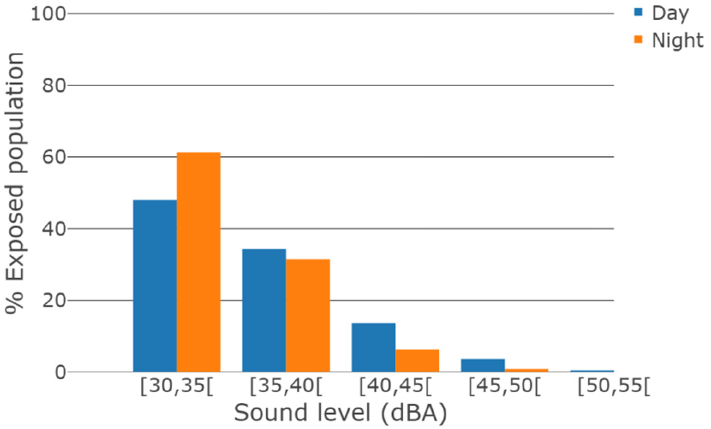
Figure 5. Number of people in metropolitan France exposed to WT sound as a function of WT sound level for daytime and night-time meteorological conditions, normalized by the total number of people exposed to WT sound level above 30 dBA.